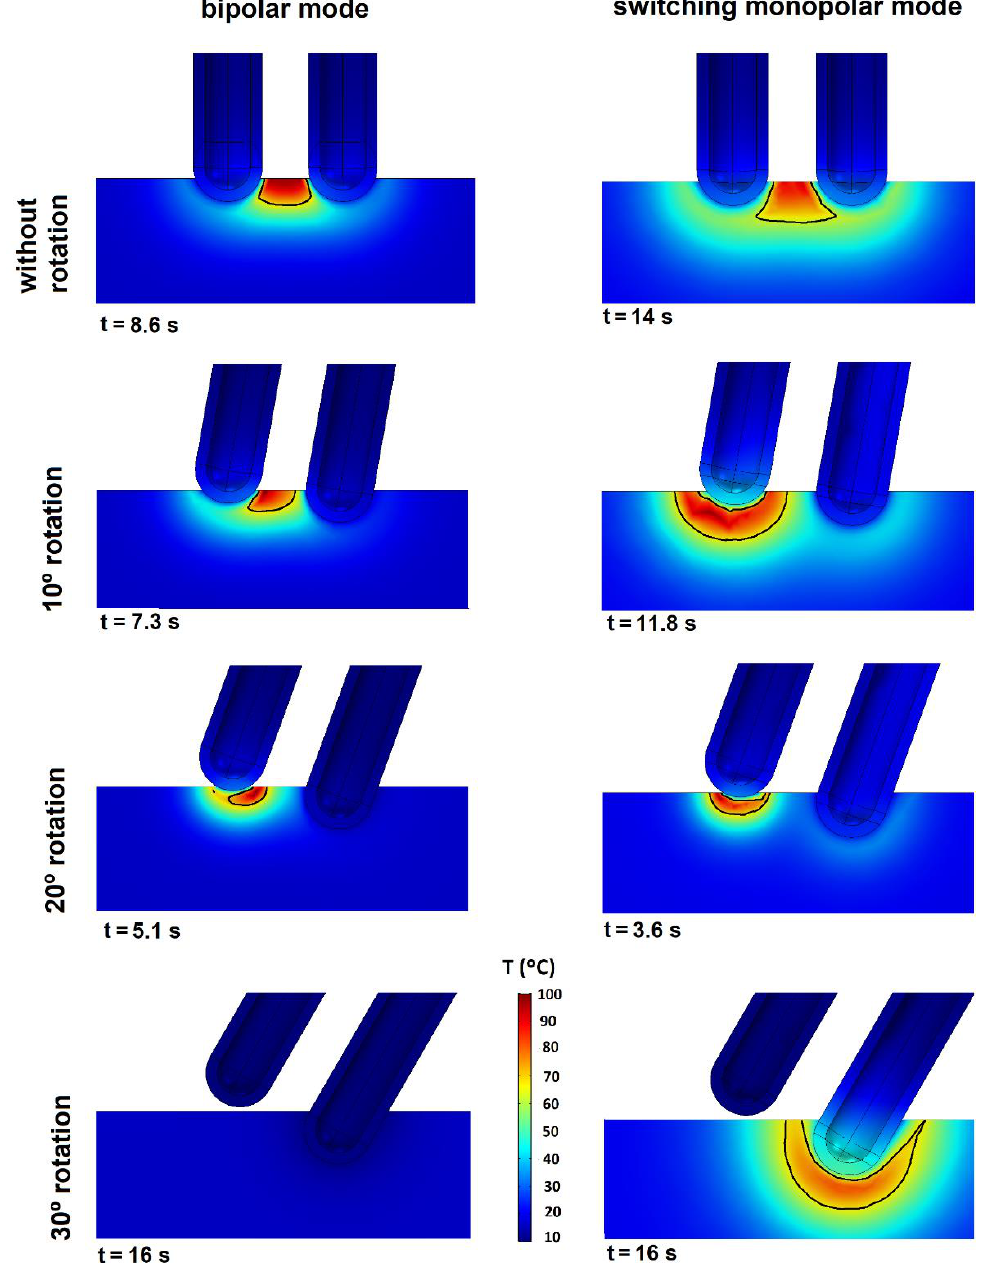
Figure 9. Temperature distribution (°C) and isosurface Ω = 1 (black line) for the BM and SMM modes in the symmetry plane of the geometry using different RF applicator angles of penetration (0, 10, 20 and 30°). Voltage values of 40 and 45 V were used for BM and SMM, respectively. f S = 4 was used in SMM. The time is the t end value in each simulation.